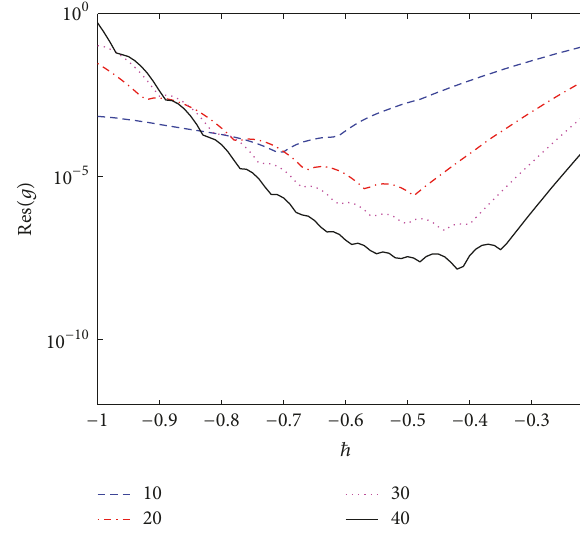
Figure 2: Residual error in 𝑔(𝜂, 𝜉) against ℏ at different iteration levels ( 𝜆 = 1, 𝜎 = 𝛾 = 0.5, Pr = 3, Sc = 2, 𝜉 = 0.45 ).